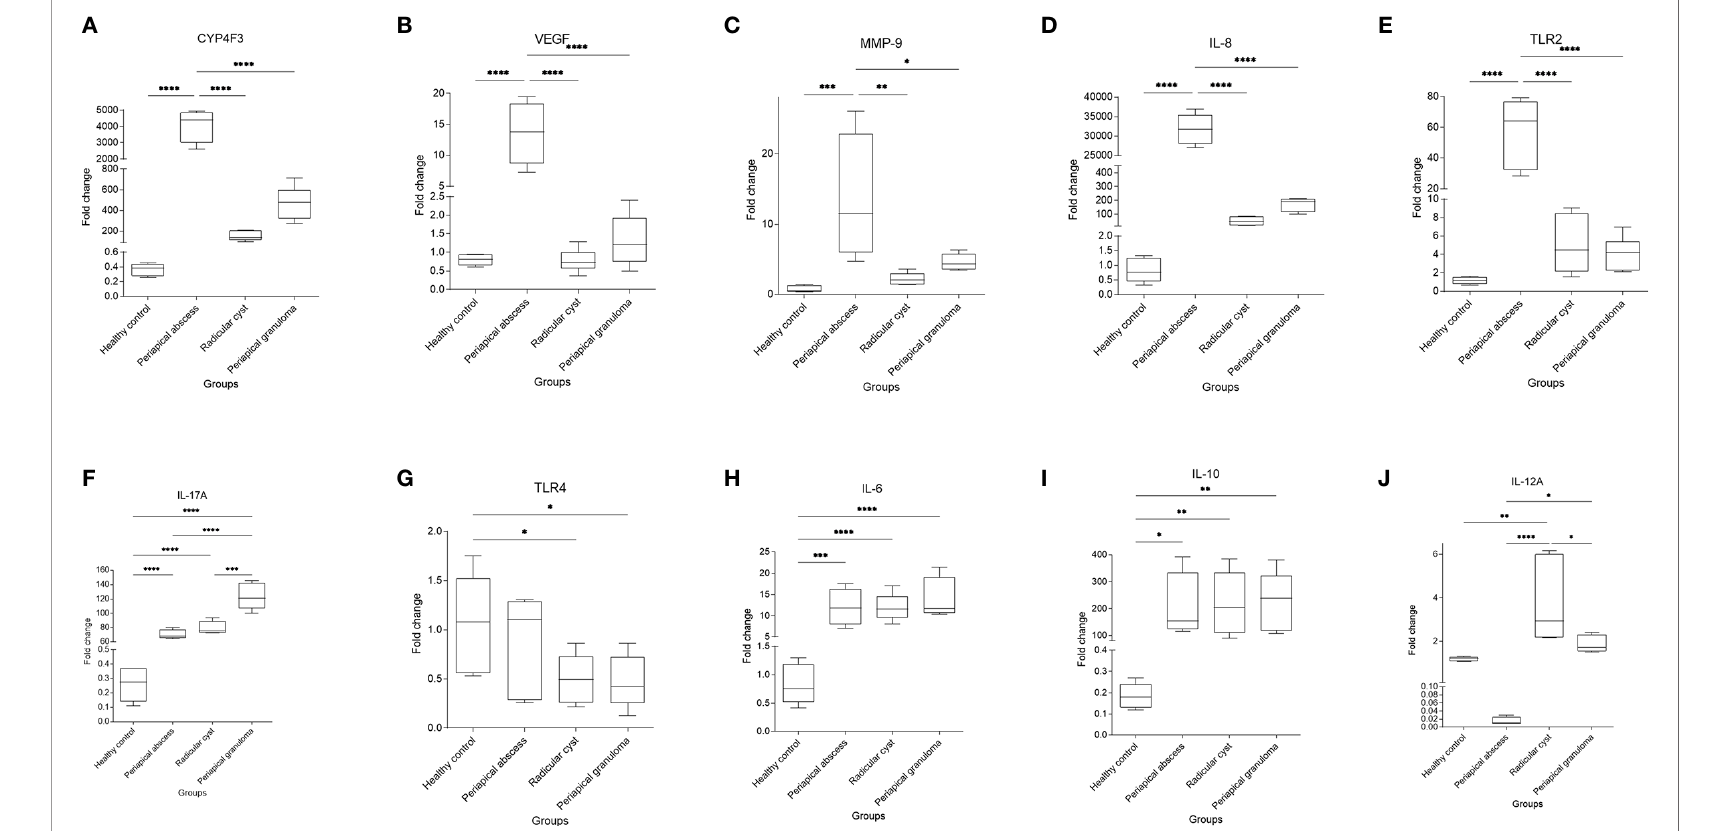
FIGURE 6 | Quantitative real-time PCR of selected genes identi fi ed in correlation to enriched pathways in periapical lesions compared with healthy control. Ten clinical samples in each group were investigated and each sample was replicated three times. The data display the fold change in gene expression between groups. The data were analyzed by one-way analysis of variance (ANOVA) using Tukey ’ s multiple comparisons test. P -value ≤ 0.05 was considered as signi fi cant. (A) CYP4F3. (B) VEGF. (C) MMP-9. (D) IL-8. (E) TLR2. (F) IL-17A. (G) TLR4. (H) IL-6. (I) IL-10. (J) IL-12A. * reveals that P -value < 0.05, ** reveals that P -value < 0.01, *** reveals that P -value < 0.001, **** reveals that P -value <